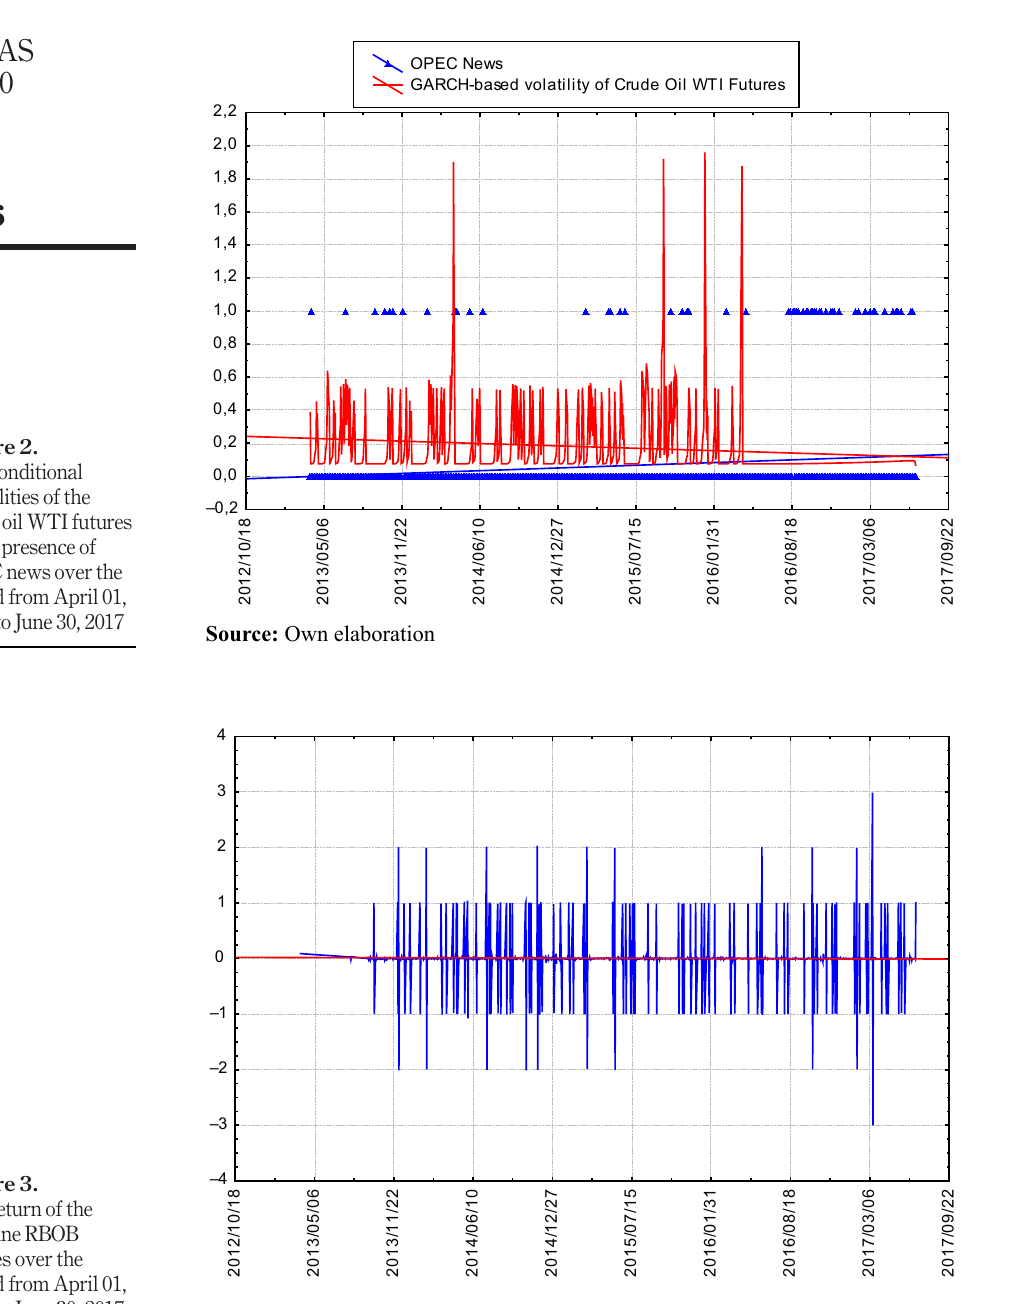
Figure 3. The return of the gasoline RBOB futures over the period from April